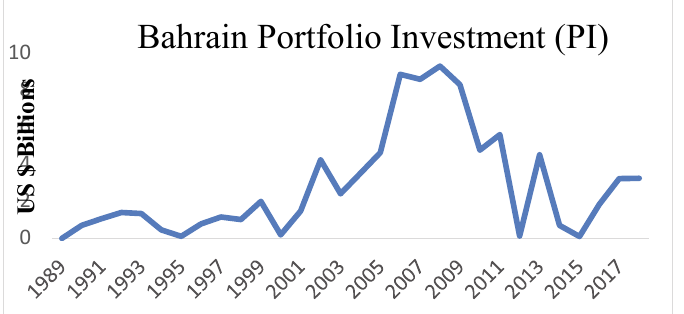
Fig. 2. Portfolio Investment in Bahrain (PI) for the 1989-2018